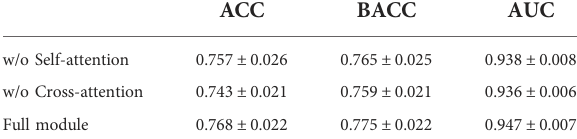
TABLE 4 Ablation study of the proposed